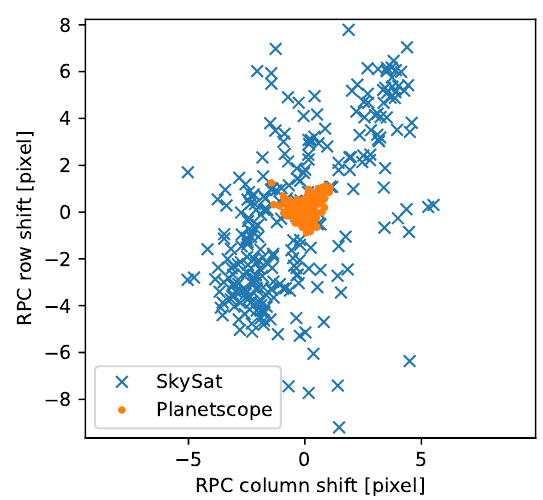
Figure 3. Image space RPC bias corrections for SkySat Triplet and PlanetScope imagery.